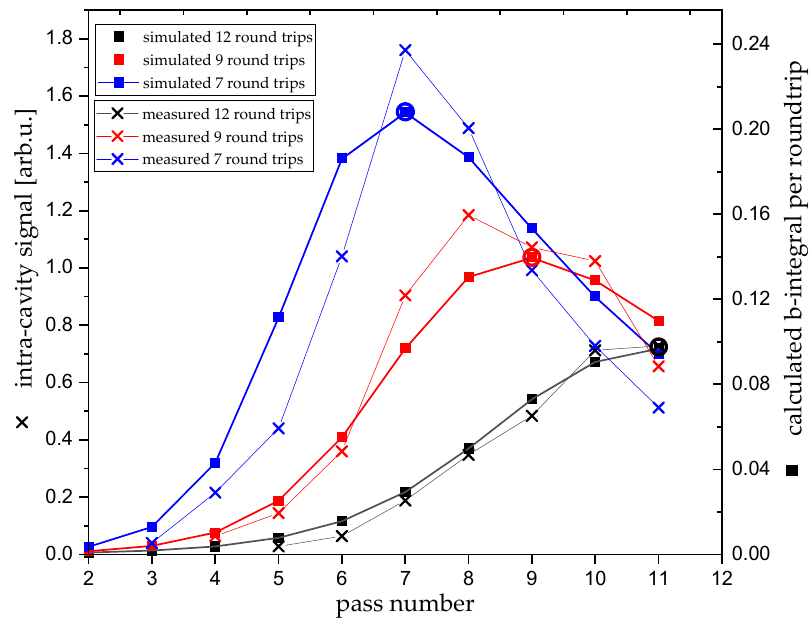
Figure 5. Measurement vs. calculation of the build-up in a regenerative amplifier and the B-integral per roundtrip. The crosses are showing the intracavity signal during build-up, measured by a photodiode placed behind one of the regenerative amplifier end mirrors. In comparison to that, the rectangles show the B-integral per pass during amplification for each setting respectively. The theoretical point of gain saturation, optimal for extraction, is marked by circles respectively. Table 2. Roundtrips till gain saturation vs. accumulated B-integral for fixed outcoupling after 12 roundtrips.